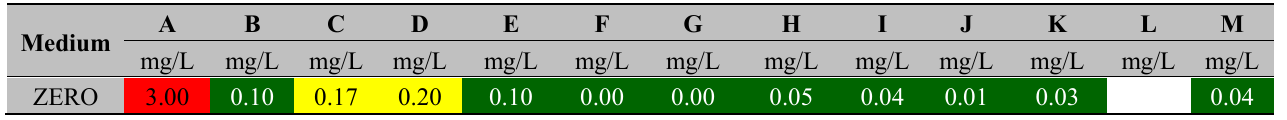
Note: a The reading was recorded after 8 min.